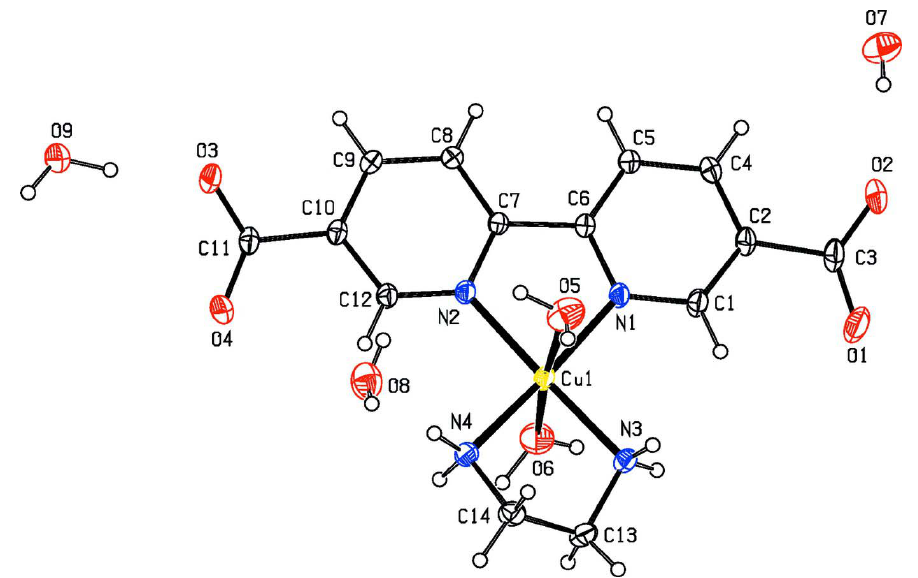
Figure 1 The molecular structure of the title molecule, with the atom-numbering scheme. Displacement ellipsoids are drawn at the 40% probability level.